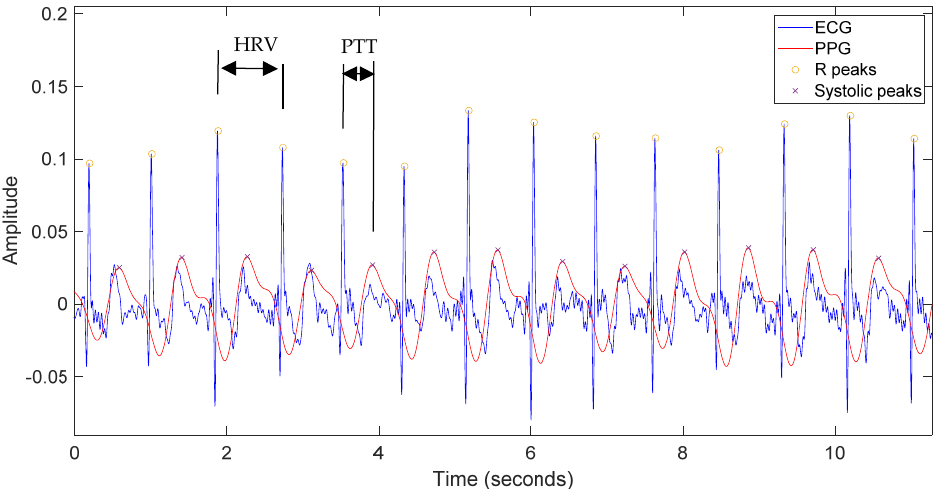
Figure 10. Filtered ECG signal (in blue) and filtered PPG signal (in red) for 10 s. HRV parameter is obtained from the ECG signal by calculating the time between the R ‐ peaks. To calculate the PTT parameter, it is necessary to measure the time between the R ‐ peak of the ECG signal and the next peak in the PPG signal.